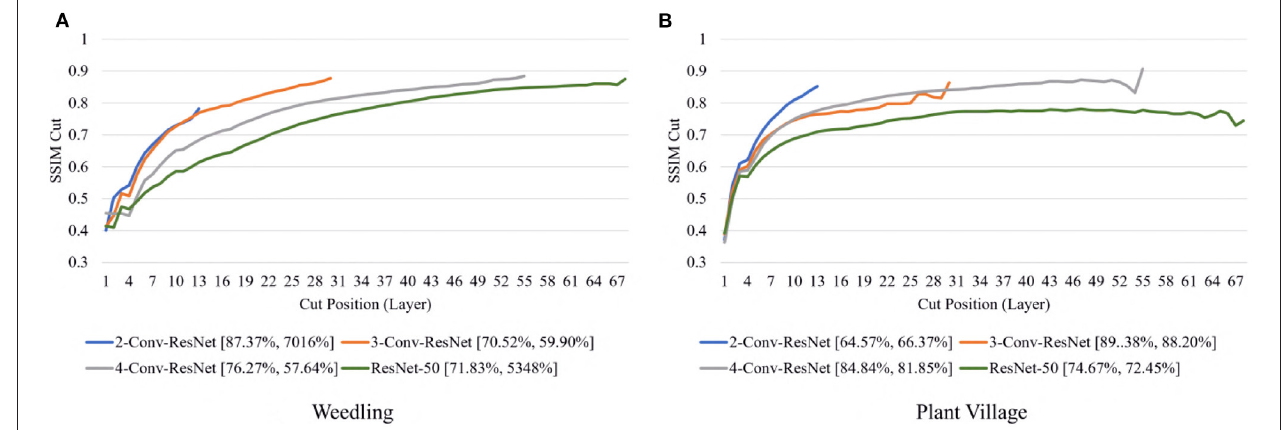
FIGURE 10 | Comparison of the Cut Position (Layer) VS SSIM cut curve for ResNet models for (A) Weedling and (B) Plant Village dataset at Epoch (1). The value in the legend of the chart indicate the training and testing accuracy of the model.